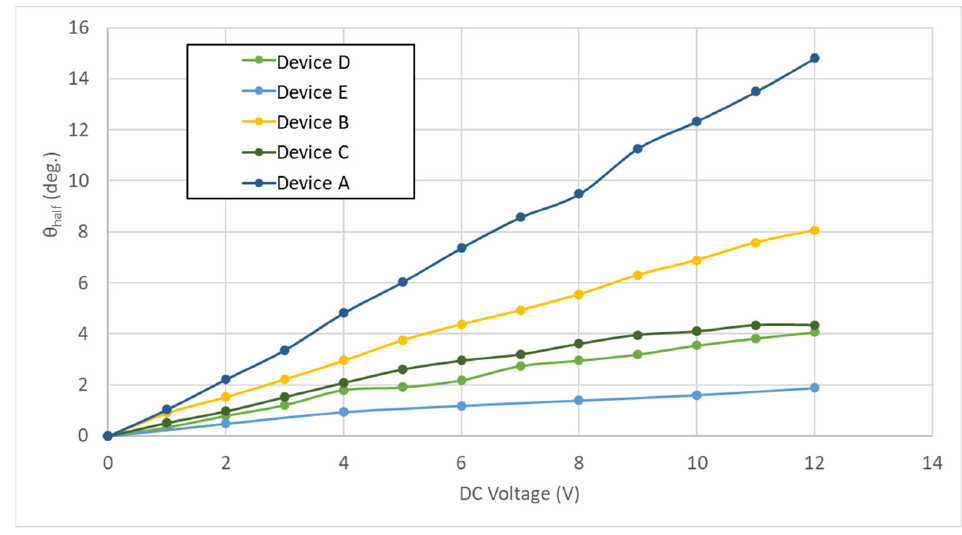
Figure 6. Static characteristics: optical half angle θ half vs. dc voltage for different devices.